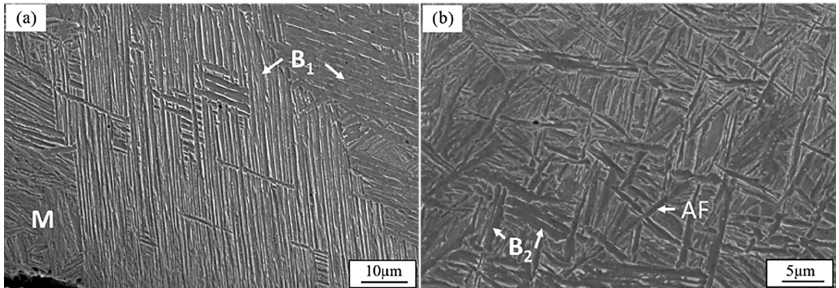
Figure 3. SEM micrographs of the mixed microstructures in the surface layer. ( a ) Mixed microstructure of lath martensite and B 1 blocks of upper bainite in the 0–50 μ m area. ( b ) Mixed microstructure of acicular ferrite and B 2 blocks of upper bainite in the 50–200 μ m area.